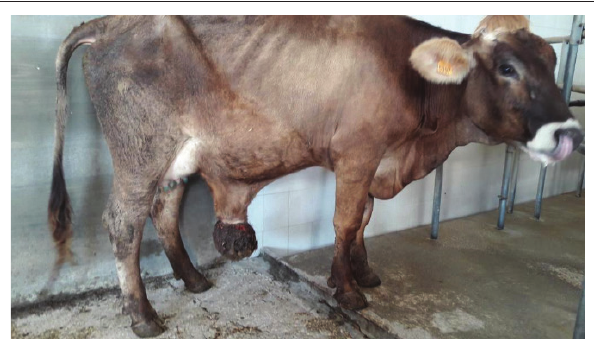
FIGURE 1: Cow at 6 days postpartum with poor body condition, showing a large skin mass located on the ventral abdomen in the umbilical region. The small udder is also visible.